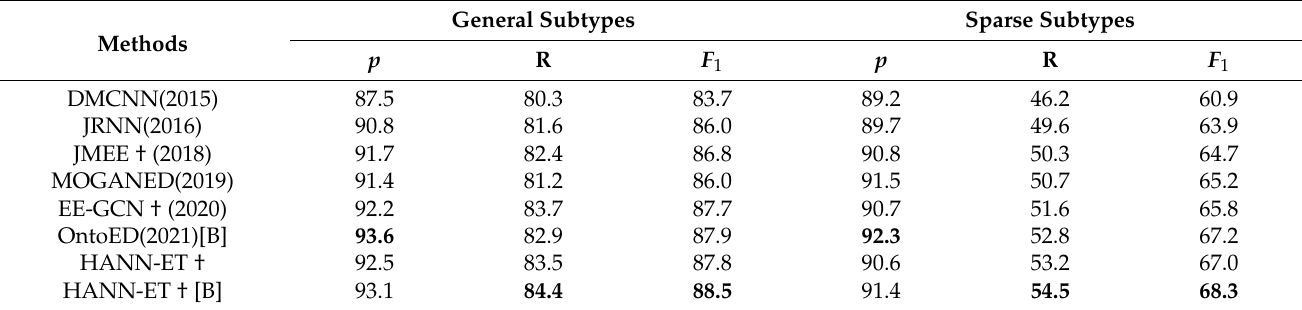
Table 7. Results of experiments on general and sparse event types, respectively